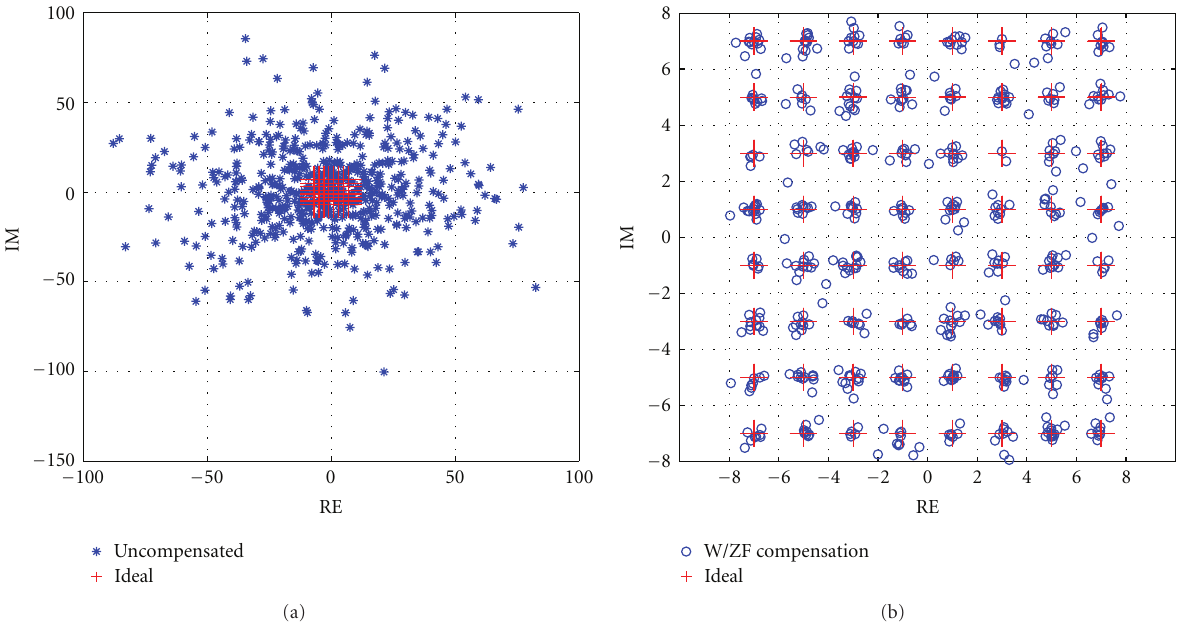
Figure 16: Measured constellation diagram of 64-QAM OFDM system before and after RF impairments mitigation. (a) Uncompensated (b) Compensated with ZF equalization.